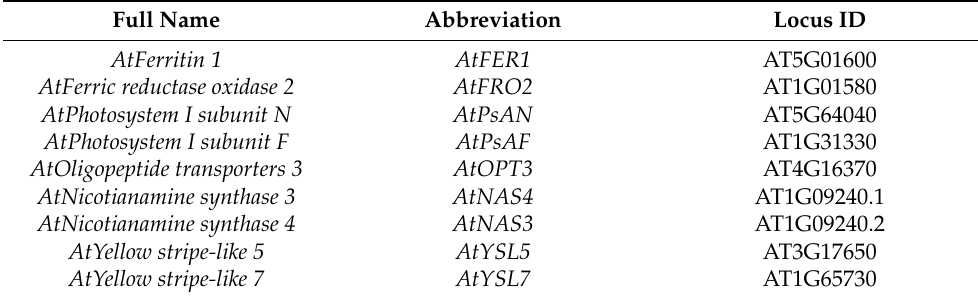
Table 1. Genes of Arabidopsis thaliana locus number and name used in this